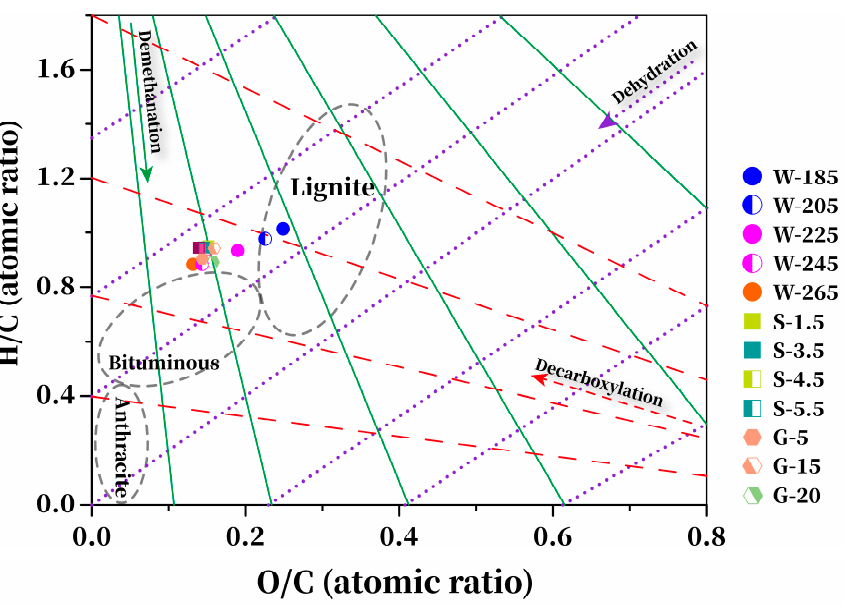
Figure 4. Van Krevelen diagram of hydrochar under three different HTC conditions and van Krevelen diagram of three typical coals in China.